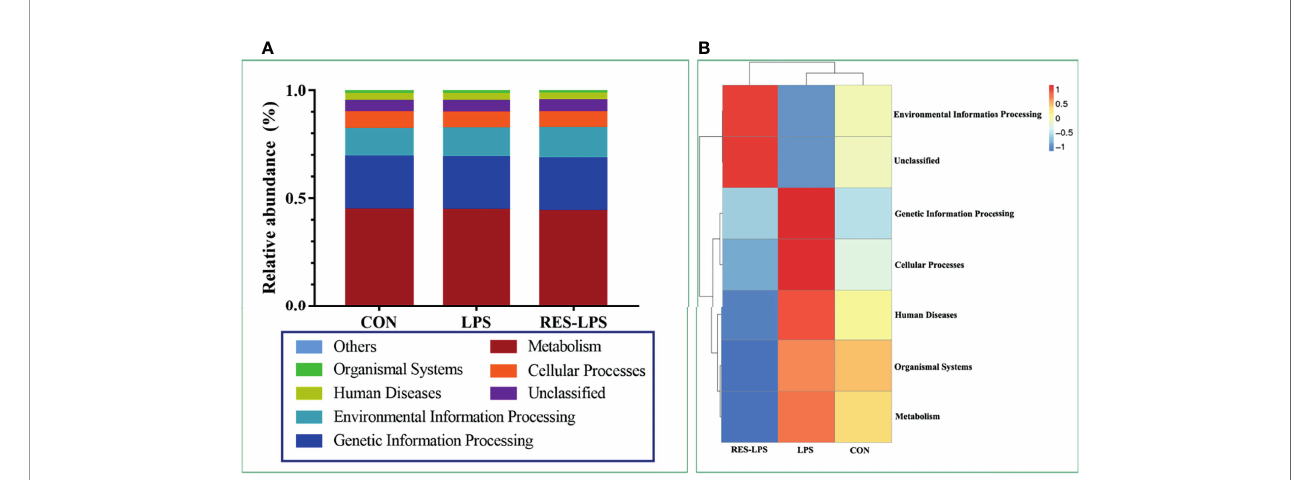
FIGURE 6 | Effects of RES on intestinal microbial function. According to the annotation results of KEGG database, Tax4Fun functional annotation relative abundance histogram (A) for the top 10 functions and functional annotation clustering heat map (B) were made among CON, LPS and RES-LPS groups.